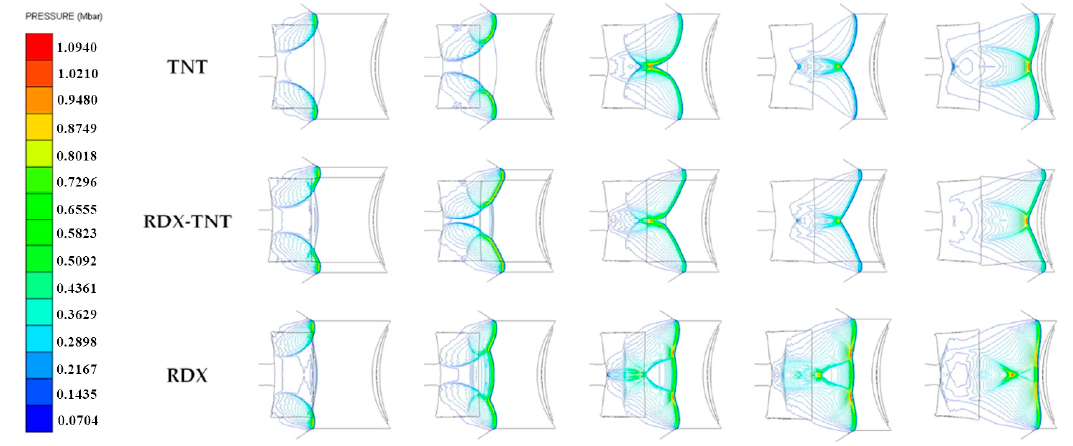
Figure 5. Propagation process of detonation waves in three shaped charge structures: OSC (TNT); DLSC (RDX-TNT); OSC (RDX).